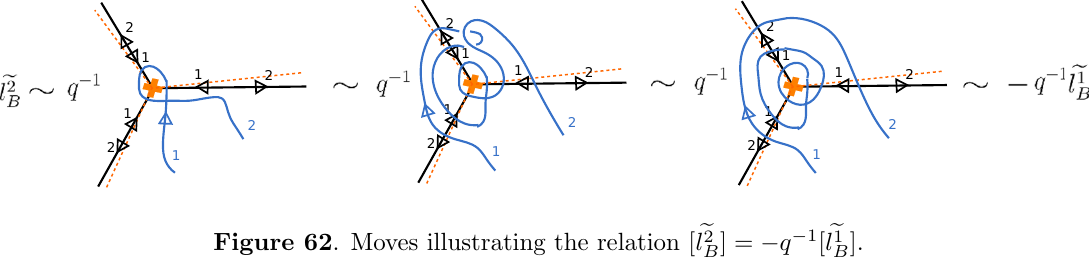
] = (cid:0) q (cid:0) 1 [ e l 1 B B